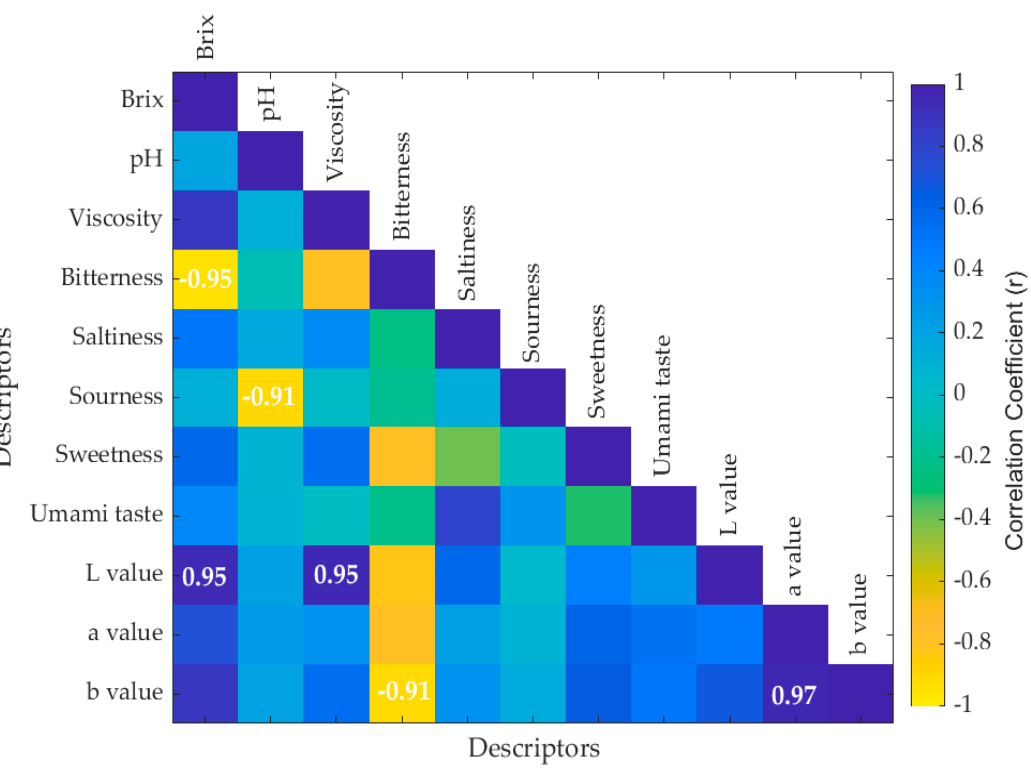
Figure 3. Results from the correlation matrix. Those with the values in the boxes represent the significant correlations ( p < 0.05). The color bar represents the correlation coefficient (r) with the blue side being positive correlations and the yellow side the negative correlations. The x-axis and y-axis represent the descriptors.